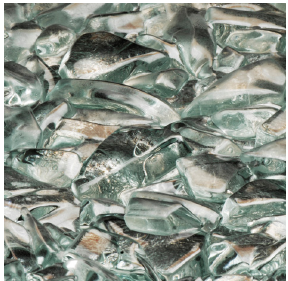
Figure 3: Fused glass shards – regular arrangement, short heat exposure.